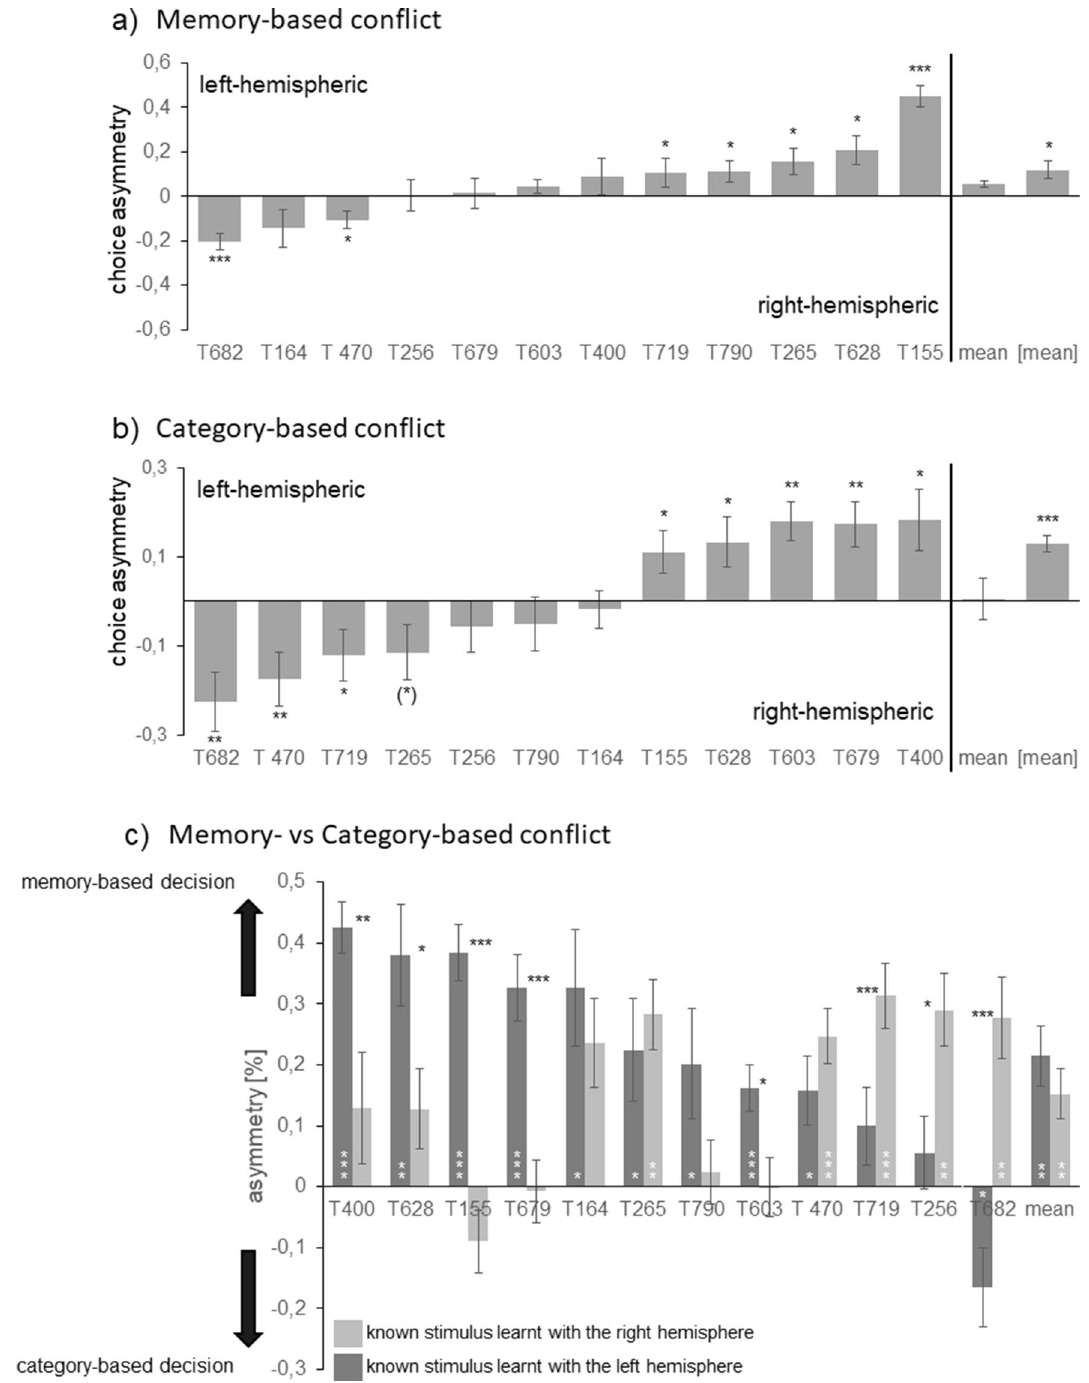
Figure 3. Decision asymmetry for different conflict types—( a ) memory-, ( b ) category-based conflicts (numbers represent single pigeons): positive values indicate left- and negative values right-hemispheric dominance. Absolute values ([mean]) but not mean decision asymmetries of all pigeons differ significantly from zero. ( c ) Memory- versus category-based conflicts: positive values indicate a memory-, negative values a category-based decision dominance. In mean, the pigeon group decides for the known stimulus but degree of left- and right-hemispheric memory-based decision dominance differs individually (black asterisks). Bars represent standard error (* p < 0.05; ** p < 0.01, *** p < 0.001 according to t-tests for dependent samples or one sample